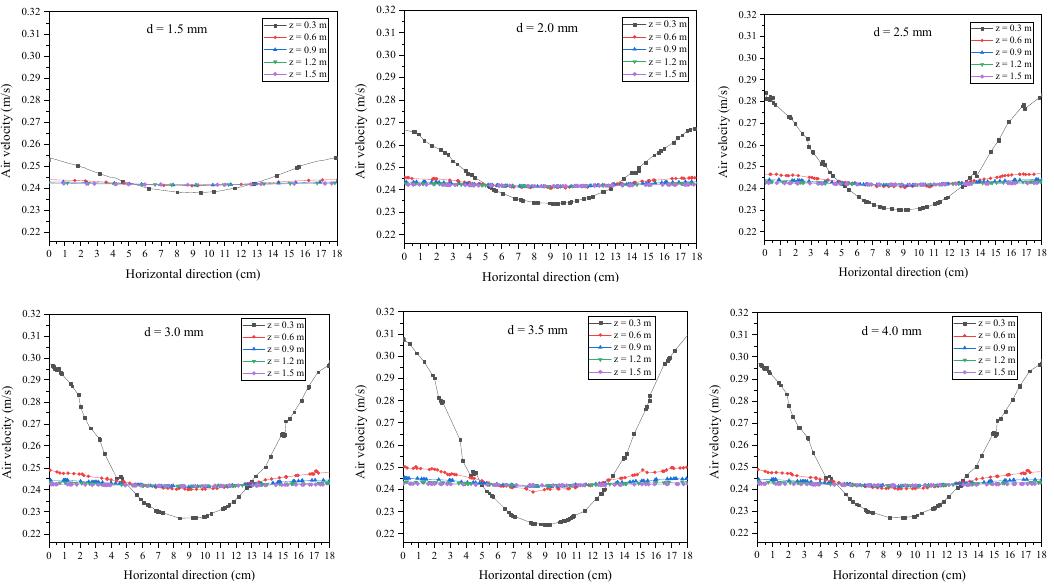
Figure 5. Air velocity variations along the horizontal direction at different orifice diameters.